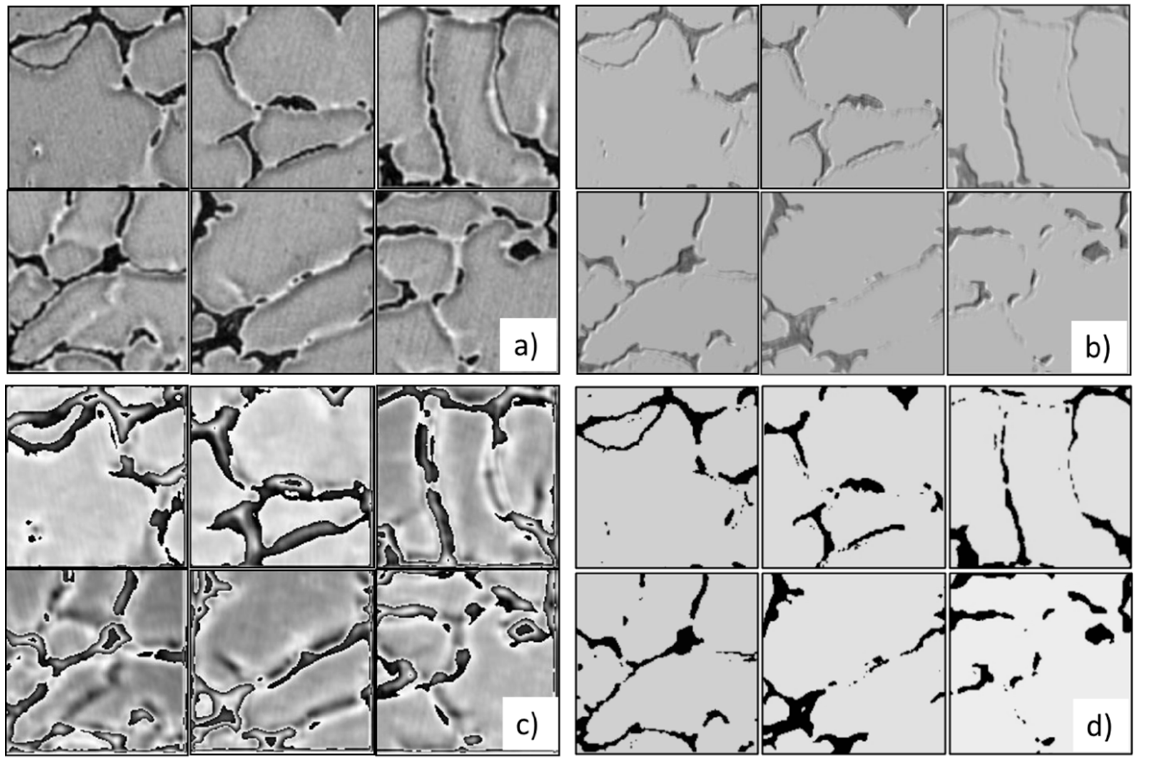
Figure 4. Results of the data augmentation processing for six micrographs images. ( a ) Original micrographs, ( b ) micrograph images extracted from convolution layer 2, ( c ) extracted from convolution layer 4, and ( d ) final micrograph images in black and white.